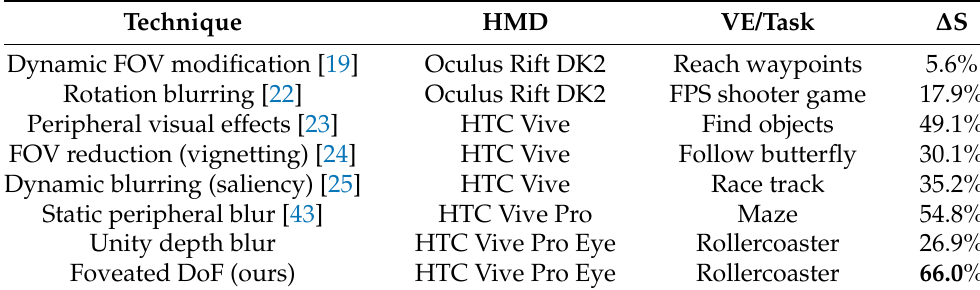
Table 3. Comparison among different techniques for reducing cybersickness. ∆ S is the reduc- tion in the mean sickness scores between the no effect condition and the best performing condi-